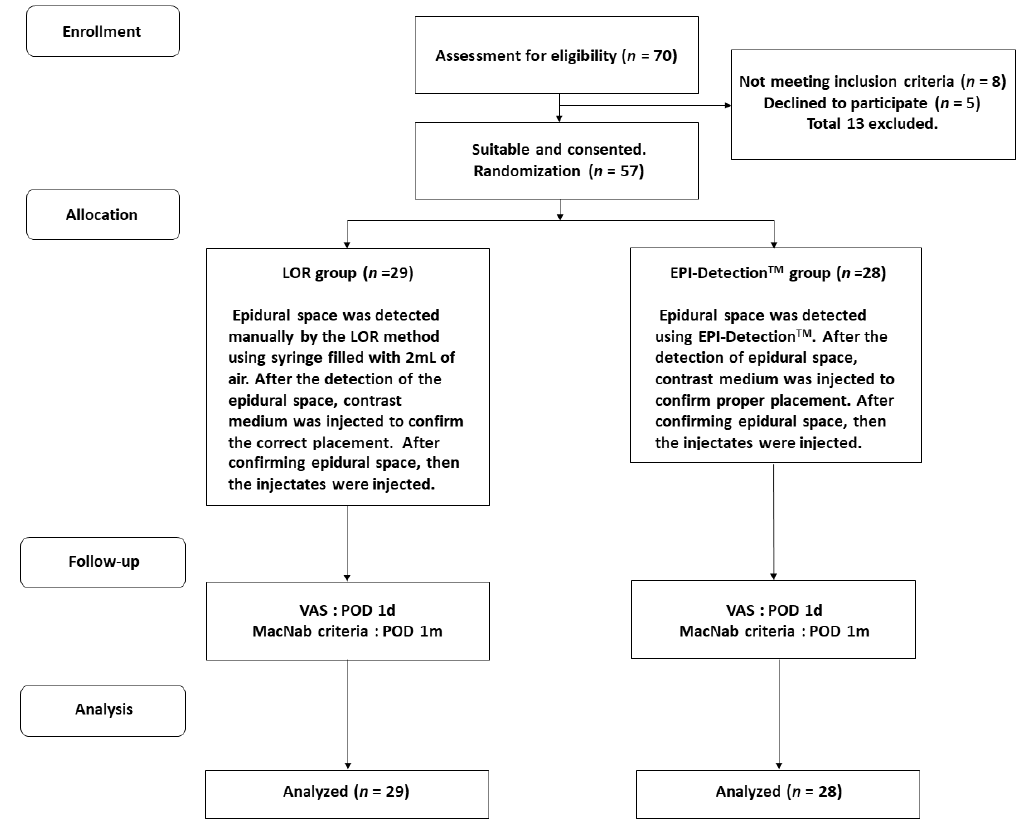
Figure 1. Flow diagram showing the method of patient recruitment. LOR, loss of resistance; VAS, visual analog scale; POD, post-operative day.